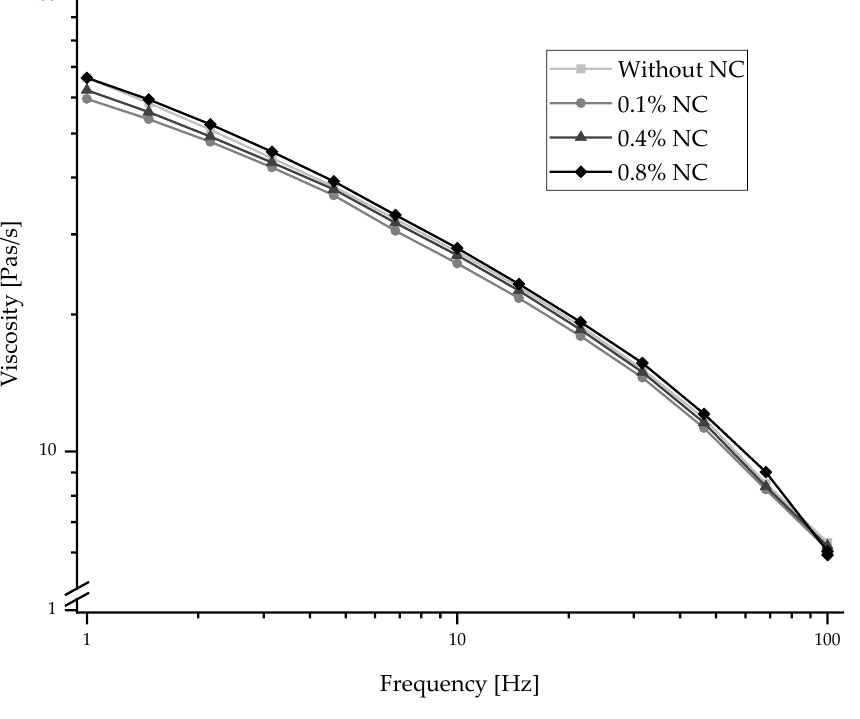
Figure 1. Viscosity of the PAN/NC spinning solutions. For the following spinning of the PAN/NC fibers, the rheological measurements showed that the solutions with the chosen NC content range can be spun with similar parameters as the reference PAN spinning